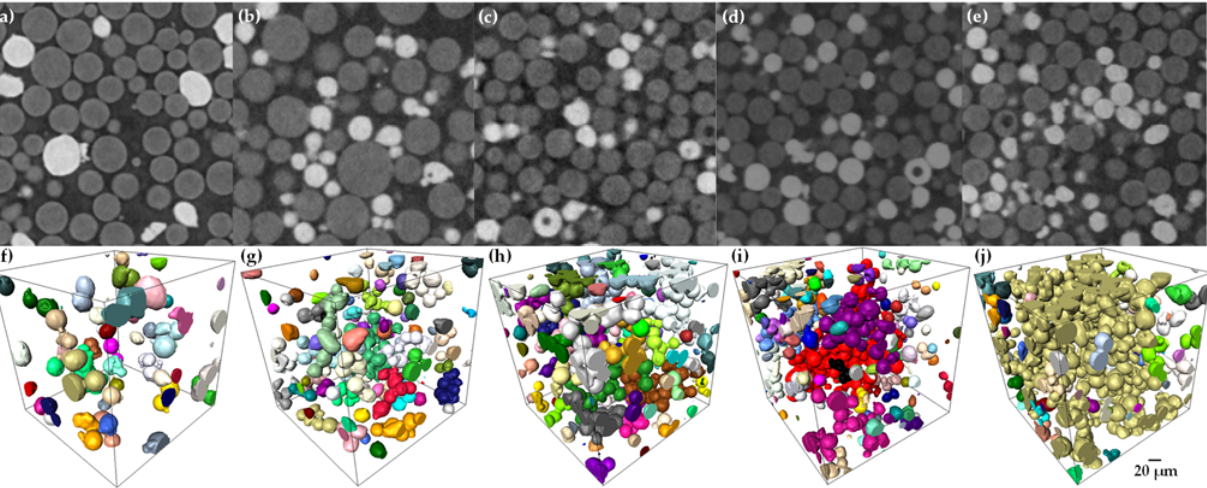
Figure 2. Two-dimensional virtual slices and 3D rendering of the CoCrMo particles of samples with different volume fractions of CoCrMo particles: ( a , f ) 10%, ( b , g ) 15%, ( c , h ) 20%, ( d , i ) 25% and ( e , j ) 30%.